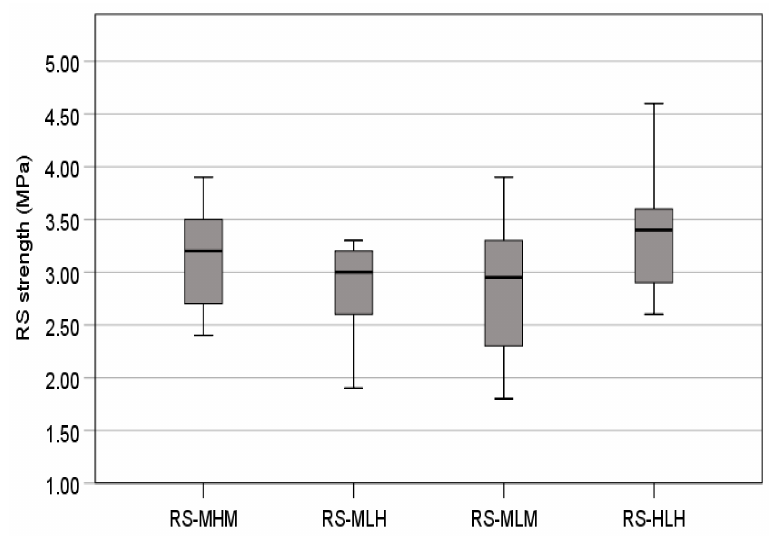
Figure 2. Rolling shear strength for each specimen